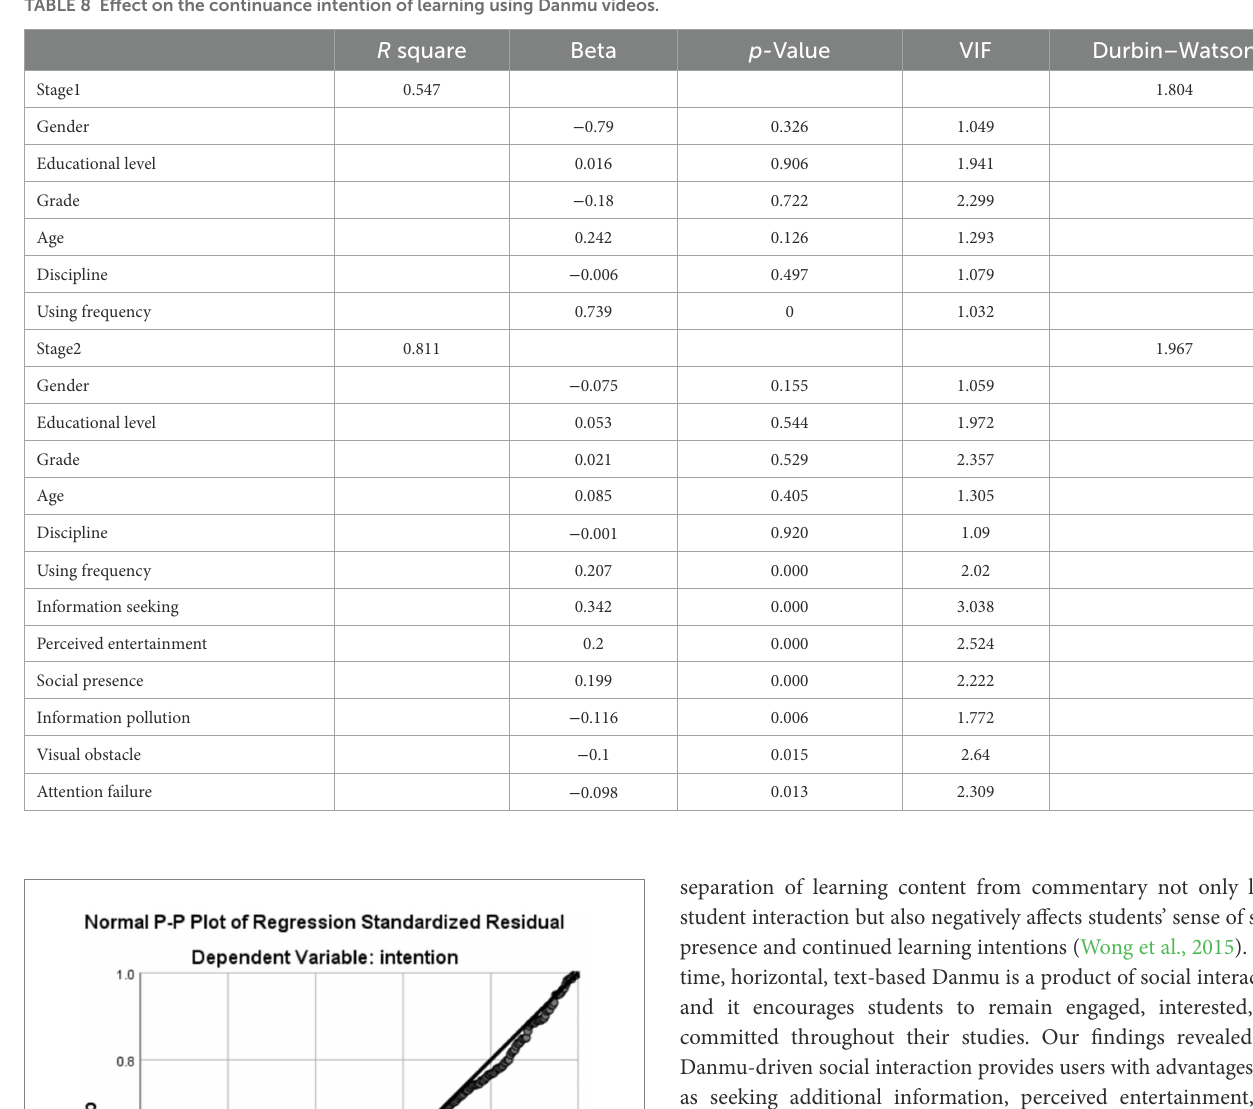
TABLE 8 Effect on the continuance intention of learning using Danmu videos.